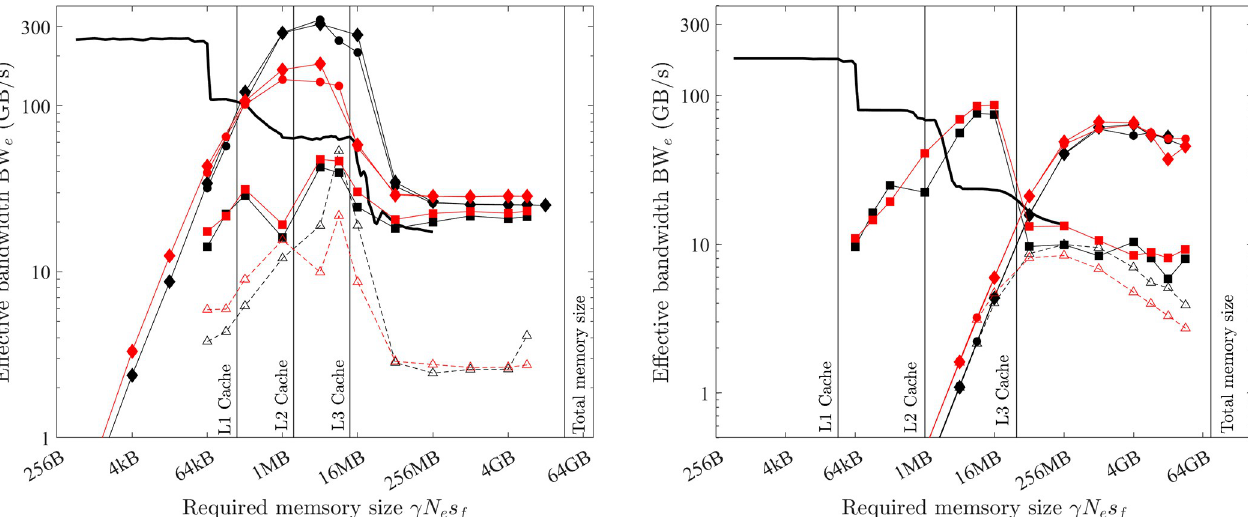
Fig 13. Optimal implementation of matrix operations on the CPU platform (double precision; solid black line = benchmarked bandwidth; lines + symbols = effective bandwidth; black = COPY2D; red = XPXPY20_2D; filled circles = OpenMP parallel for with cached access; hollow triangles = OpenMP parallel for with uncached access; filled diamonds = optimal implementation for corresponding vector operations; filled squares = XLA). (a) PC. (b) HPC.